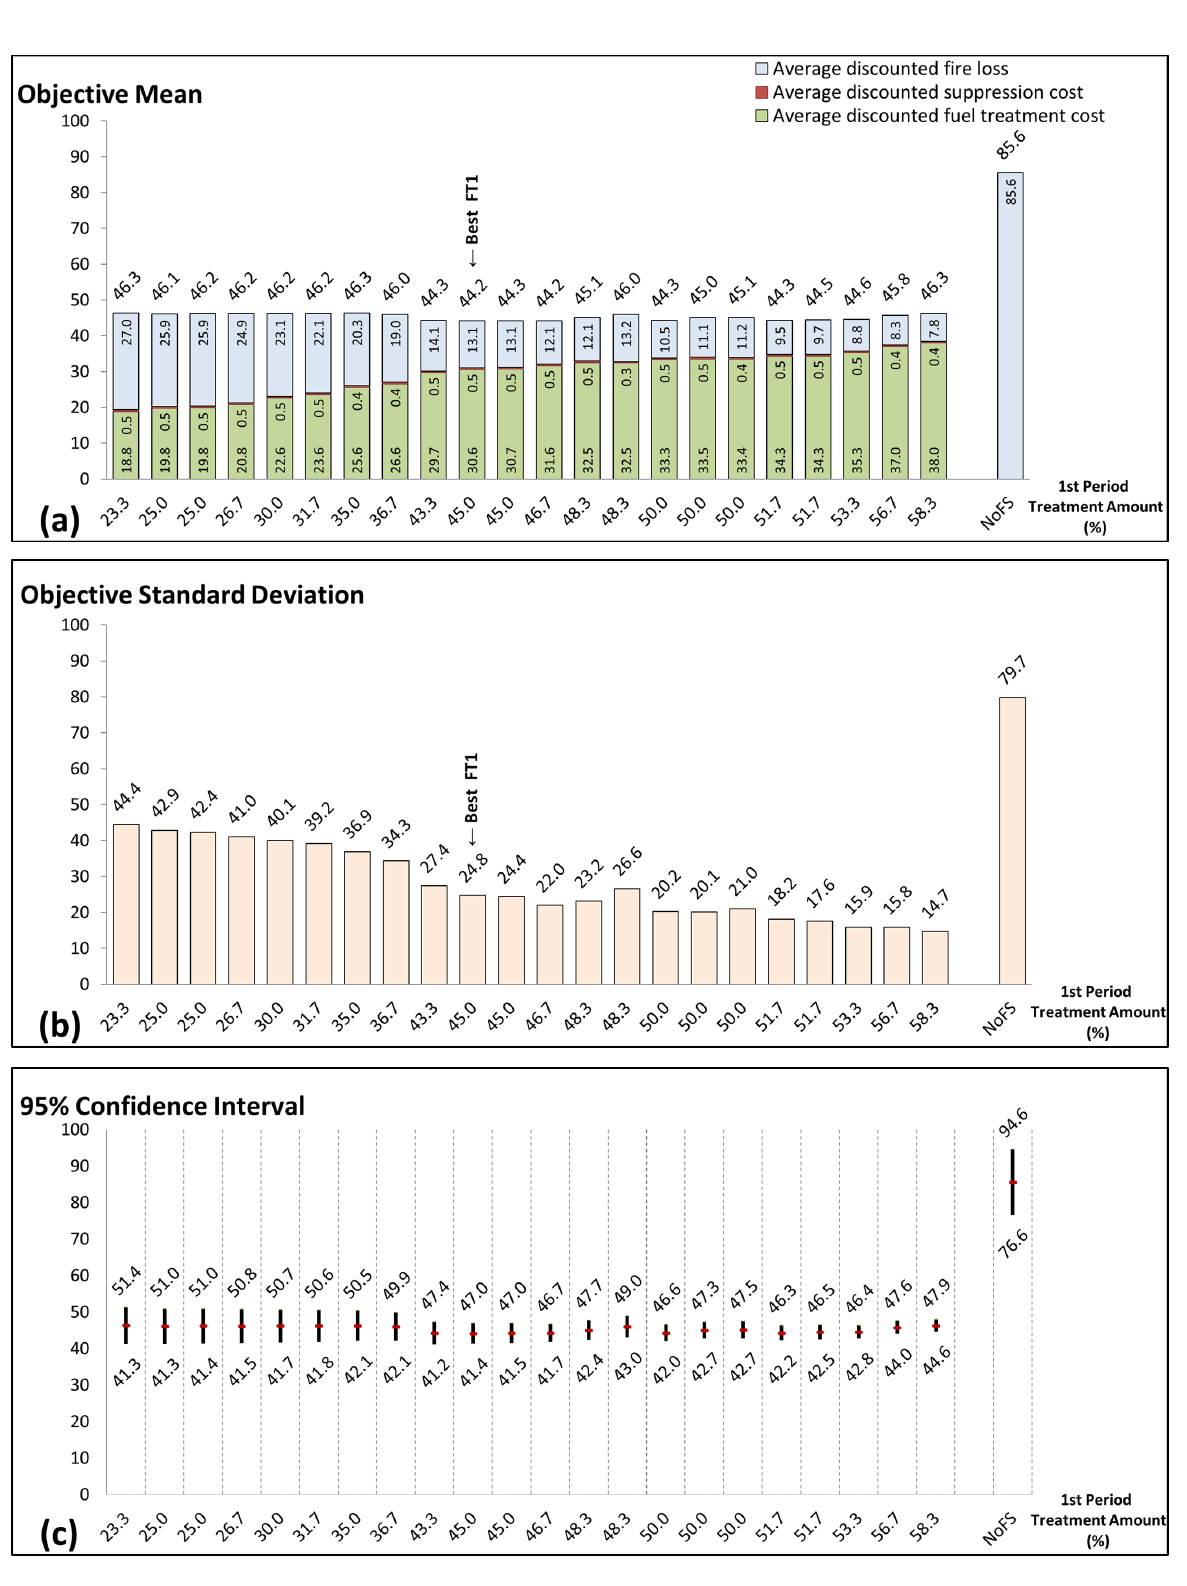
Figure 9. The best and the alternative FT1s under the assumption of high FPV. Results include: ( a ) objective function value means; ( b ) objective function value standard deviations; ( c ) 95% confidence intervals of the means.